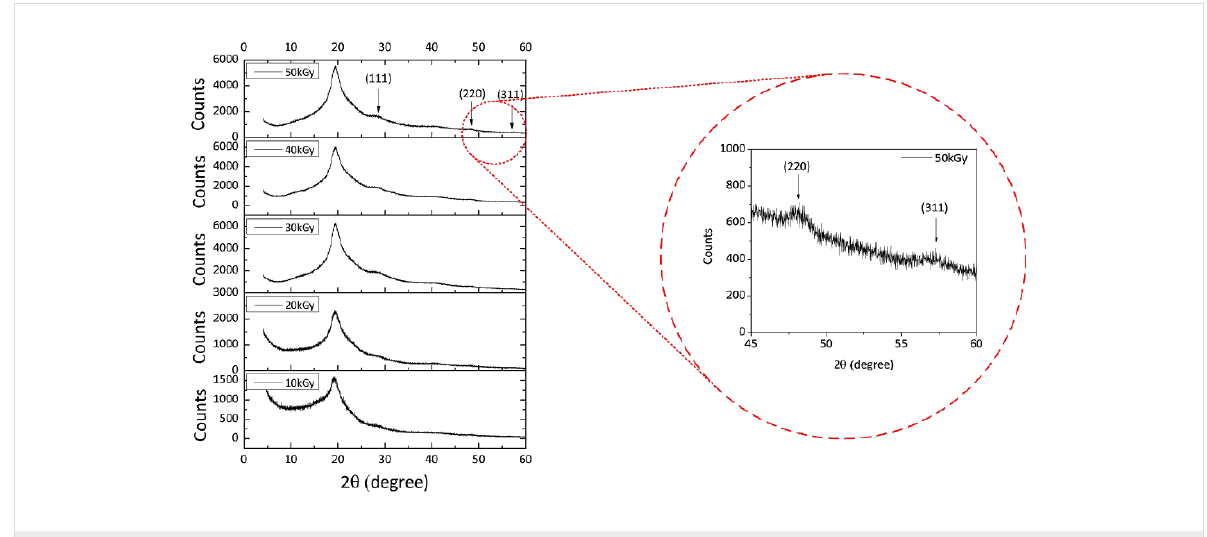
Figure 4: XRD pattern of ZnS NPs mediated by PVA from 10 to 50 kGy doses.